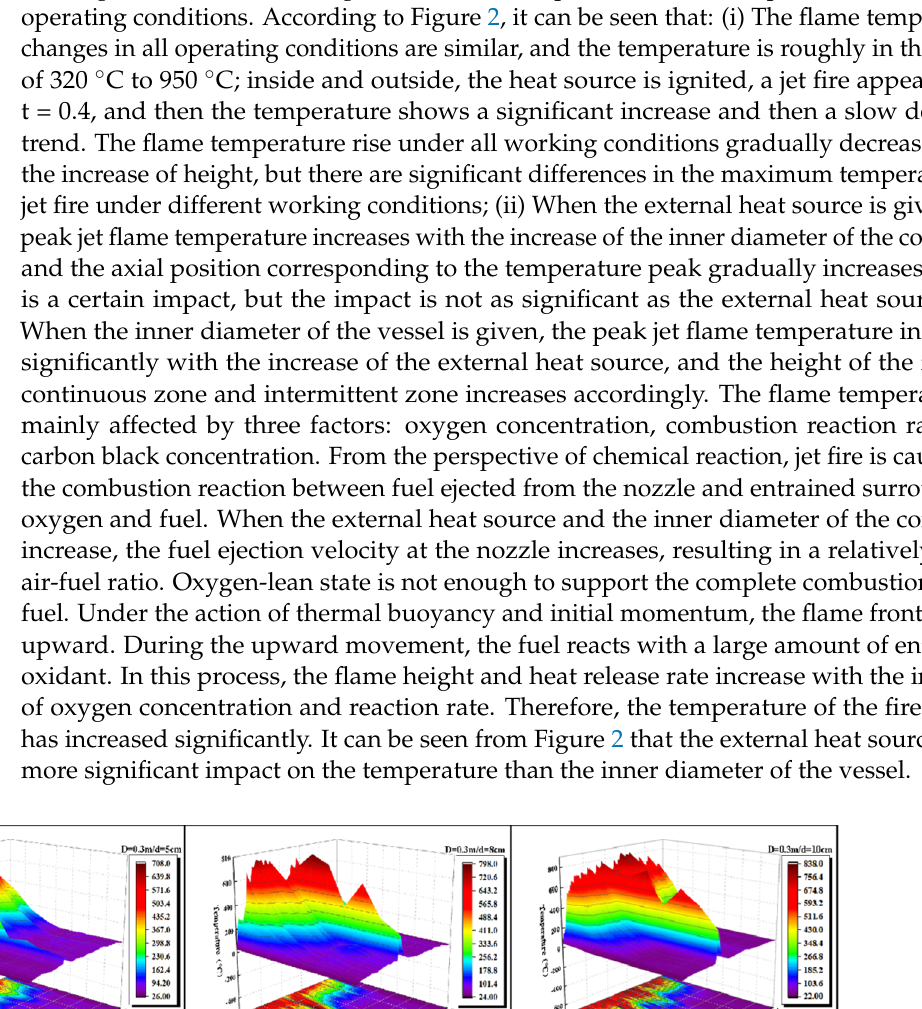
theory. Figure 3. Temperature distribution measured along the central axis of the jet fire (D = 0.4 m/d = 10 cm).